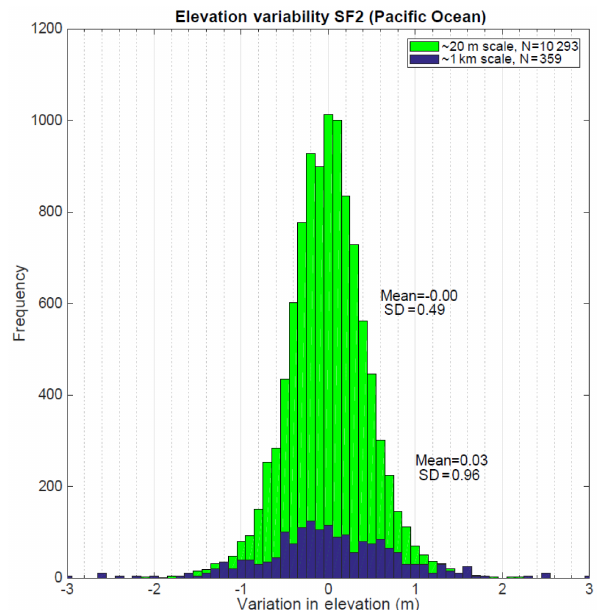
Figure 3. Histogram of the variation in sea surface elevation on the 22 August 2014 ASCENDS flight over the Pacific Ocean near the California coast. The green bars are raw data for every 0.1s integra- tion time (20m scale along track), and the blue bars are averages over 5s (1km scale along track).